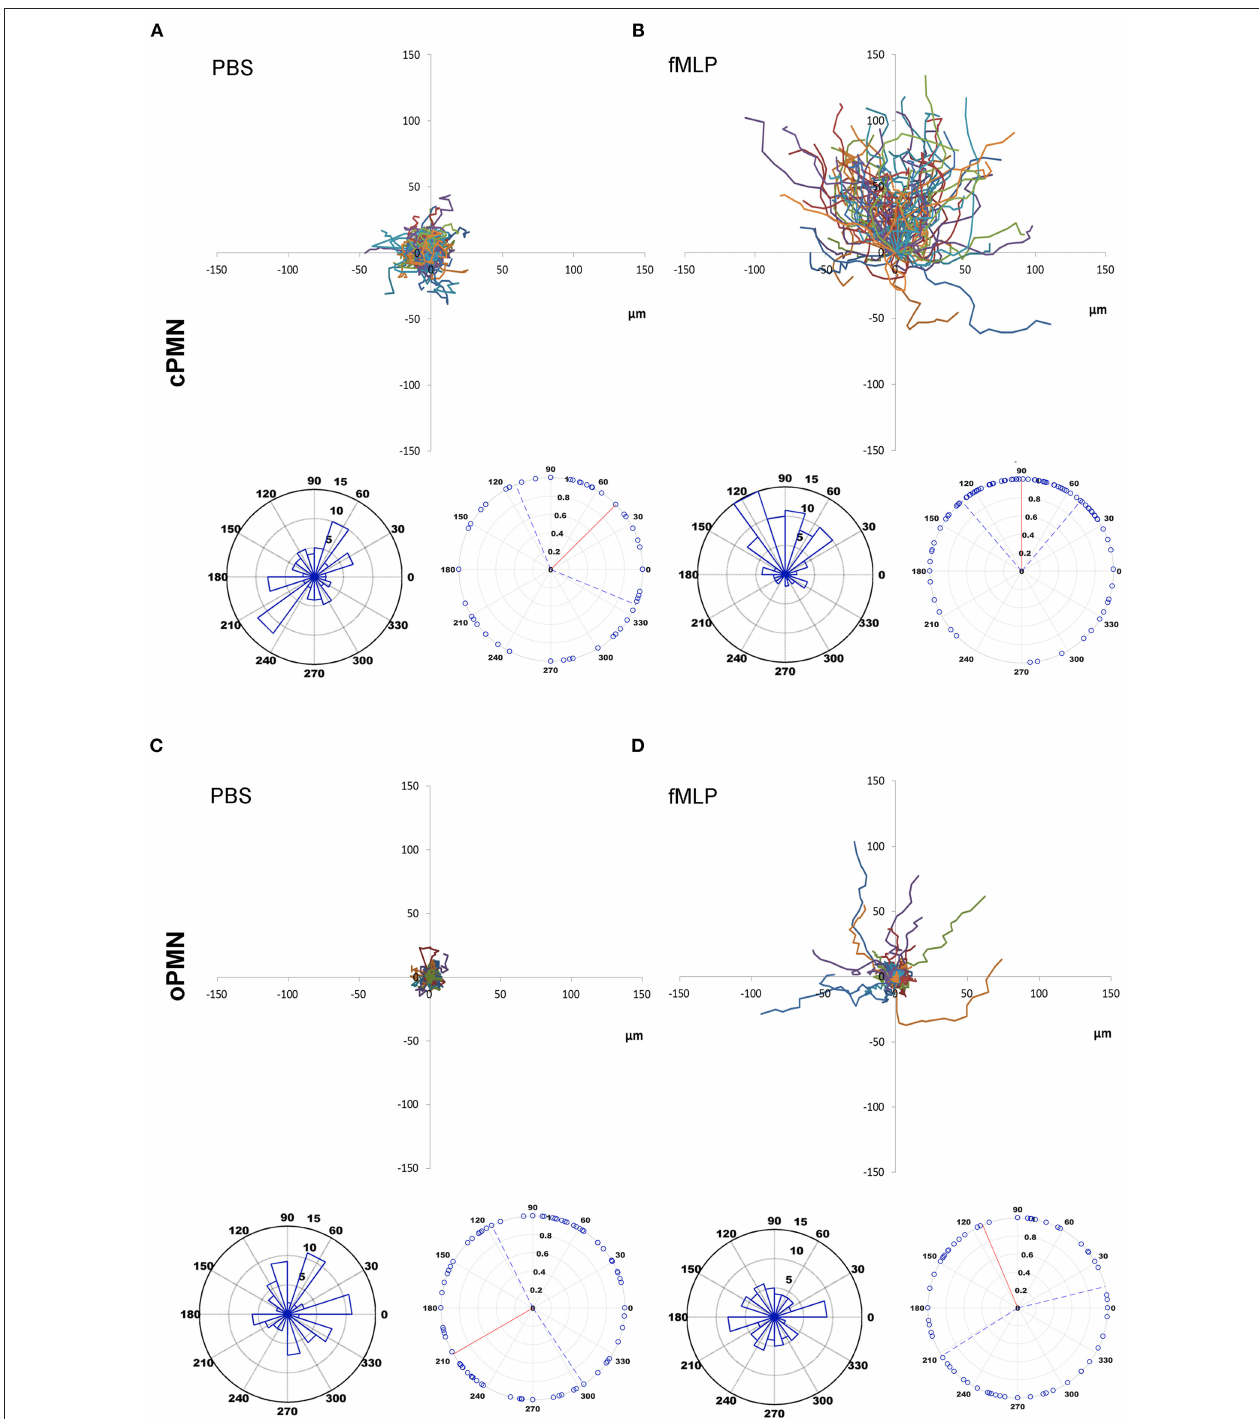
FIGURE 1 | Chemotaxis of cPMNs and oPMNs. Spider, vector, and rose plots of cPMNs (A,B) and oPMNs (C,D) in response to PBS (left panels) and the chemoattractant fMLP (right panels) over a time period of 20min. Each data set comprises three graphs: the top image is a spider plot of individual cell movement tracks. Under each spider diagram, two circular diagrams are presented; illustrating the direction of migrating cells over the whole time period of 20min. The original (in the actual experimental setup) position of PBS (A,C) and the chemotactic agent fMLP (B,D) is at the North position on all graphs. Spider diagrams show the distance and direction of movement from the original position. Each individual line illustrates the complete movement ( µ meter) of one PMN over the whole time period of 20min. Vector plots (left) demonstrate the proportion of cells (5, 10 or 15 cells per chart) in segments moving toward any given direction from their original position. Rose plots (right) demonstrate the distribution of the final angle of all cells with a vector line showing the median angle (red vector) including the interquartile range (interrupting blue vectors). All diagrams are represented on the same scale. n = 9.